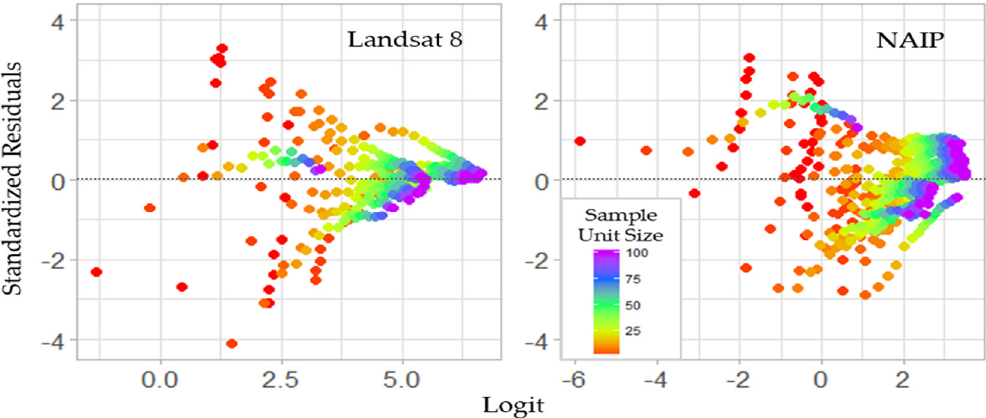
Figure A5. Scatter plot of standardized Residuals vs linear predictors (Logit) given block size for beta regression Landsat 8 and NAIP based models.